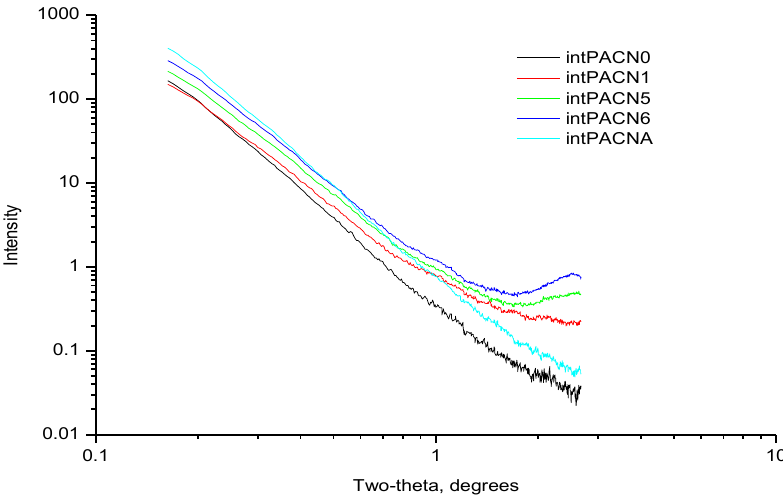
Figure 13. SAXS patterns for the PACN1, PACN5, PACN6, PACN0, and PACNna.